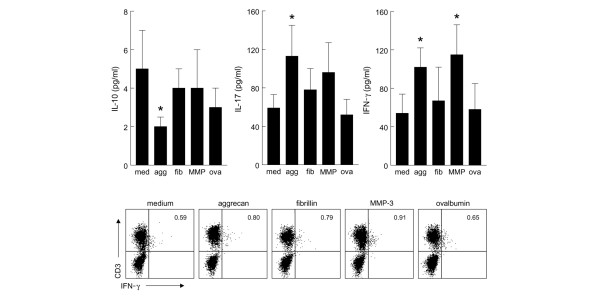
Cytokine production in short-term peptide-specific T-cell lines from patients with juvenile idiopathic arthritis (JIA). Short-term peptide-specific T-cell lines were generated from peripheral blood mononuclear cells of five patients with polyarticular JIA. After 14 days of culture, supernatants were taken for multiplex cytokine analysis and cells were stained for fluorescence-activated cell sorting (FACS) analysis. The aggrecan peptide induced significant production of interferon-γ (IFN-γ)/interleukin (IL)-17 and inhibition of IL-10 production (p < 0.05). The matrix metalloproteinase (MMP)-3 peptide induced significant production of IFN-γ. FACS analysis confirmed the presence of activated T cells. Asterisks indicate significant difference.